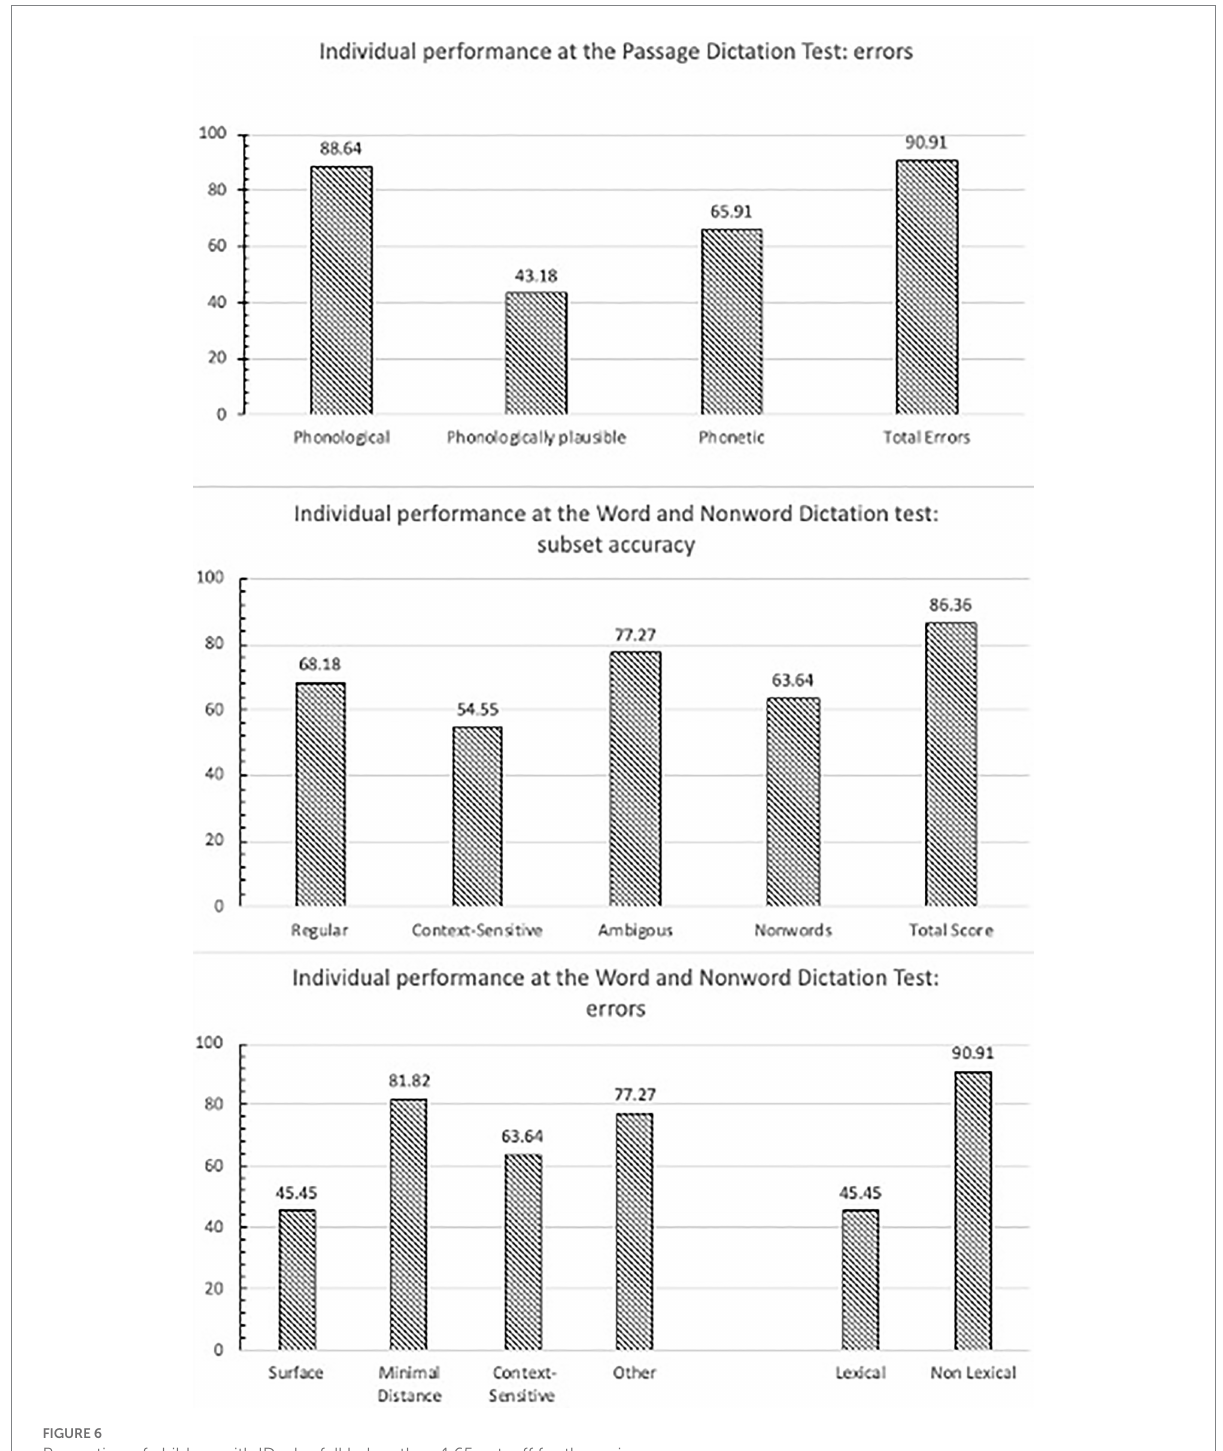
FIGURE 6 Proportion of children with ID who fell below the − 1.65 cut-off for the various